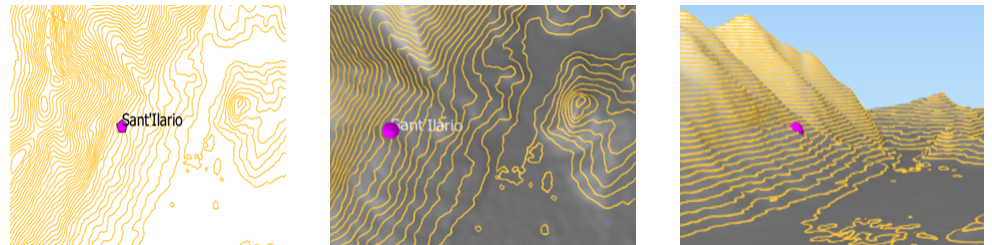
Figure 10. Three images of the terrain around the Sant’Ilario station. From left to right: a 2D map showing the contour lines near by the station; an up 3D map, and a frontal 3D map.